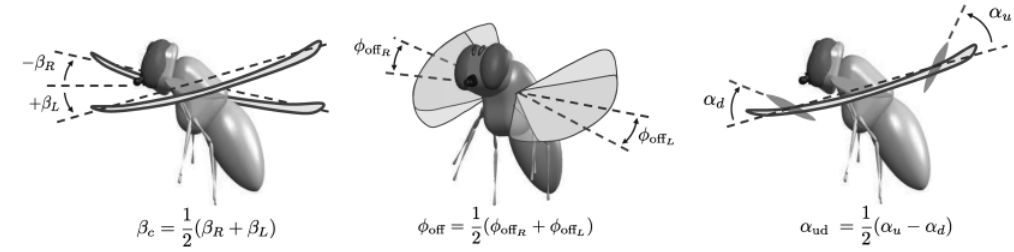
Figure 5. Definition of the different control inputs in longitudinal motions